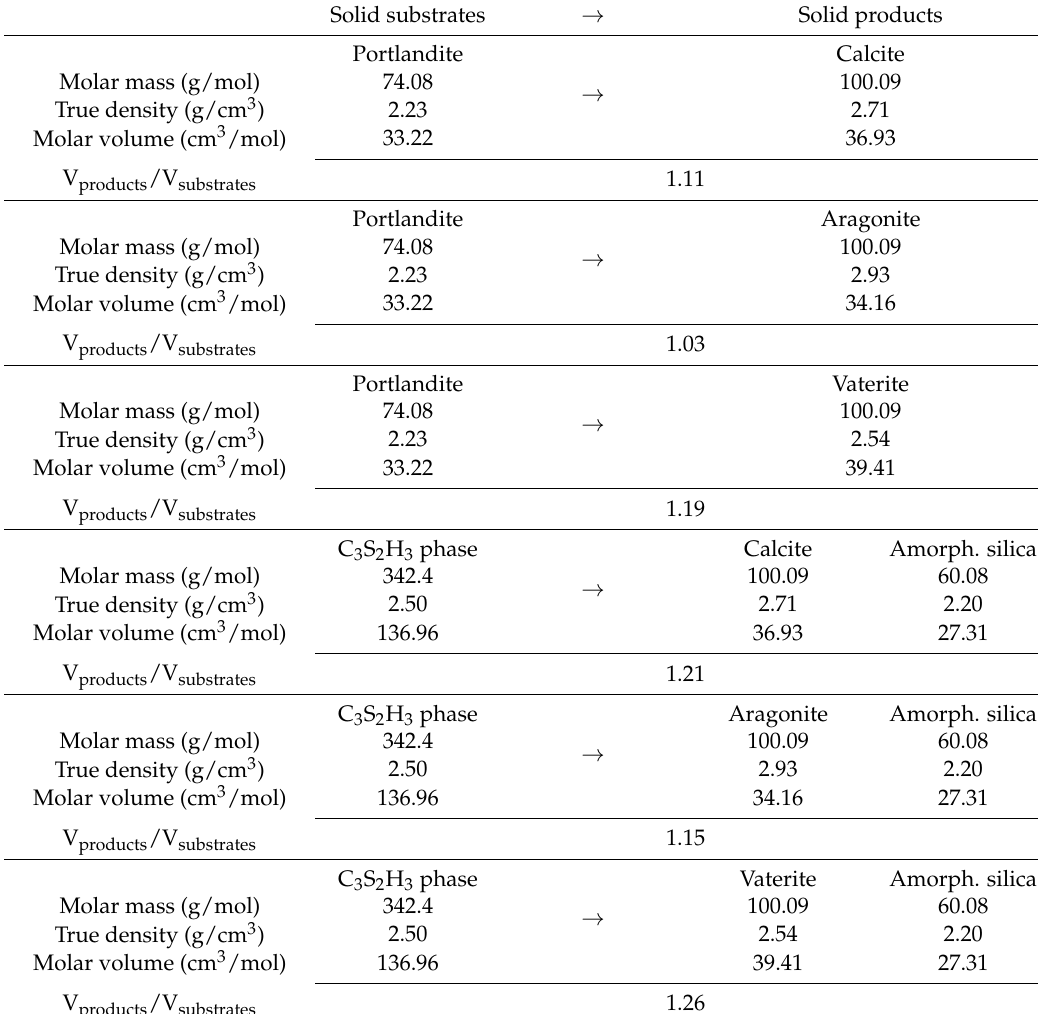
Table 4. Changes in the volumes of substrates and products as a result of carbonation